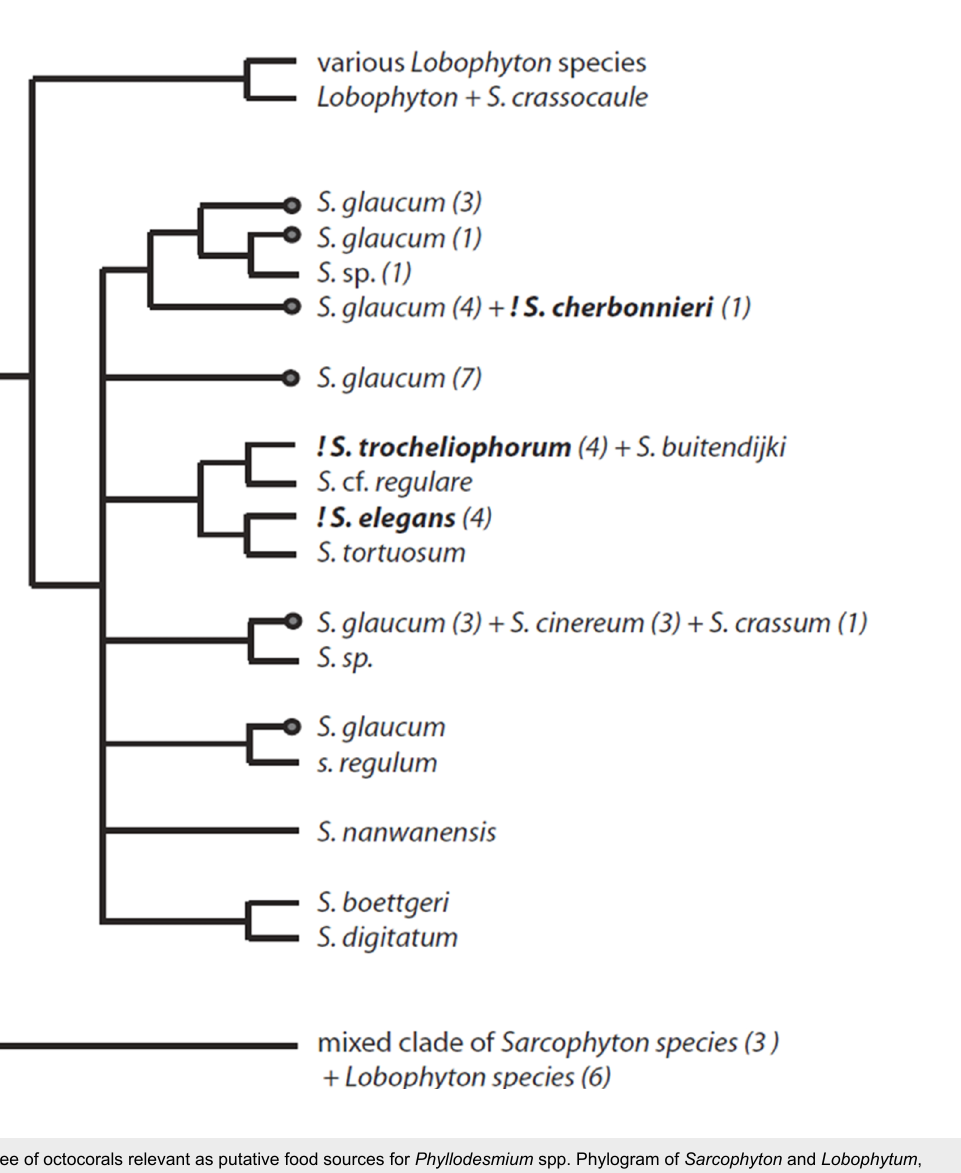
Figure 12: Phylogenetic tree of octocorals relevant as putative food sources for Phyllodesmium spp. Phylogram of Sarcophyton and Lobophytum , based on a consensus phylogram of McFadden et al. [54]. Only the Sarcophyton clade with species investigated with regard to secondary metabo- lites are given in detail. The two other clades from the original phylogram are only indicated ; Lobophytum and the mixed clade consisting of Sarco- phyton and Lobophytum species. Numbers indicate the number of specimens that represent the respective branch. Note that the single specimen of S. cherbonnieri groups with 4 specimens of S. glaucum . S. glaucum is not monophyletic, but is represented with several independent clades. The dots at the terminal branches of S. glaucum in the tree indicate that secondary metabolites are described from this species, but it is not known, from which clade. Species in bold indicate that secondary metabolites were